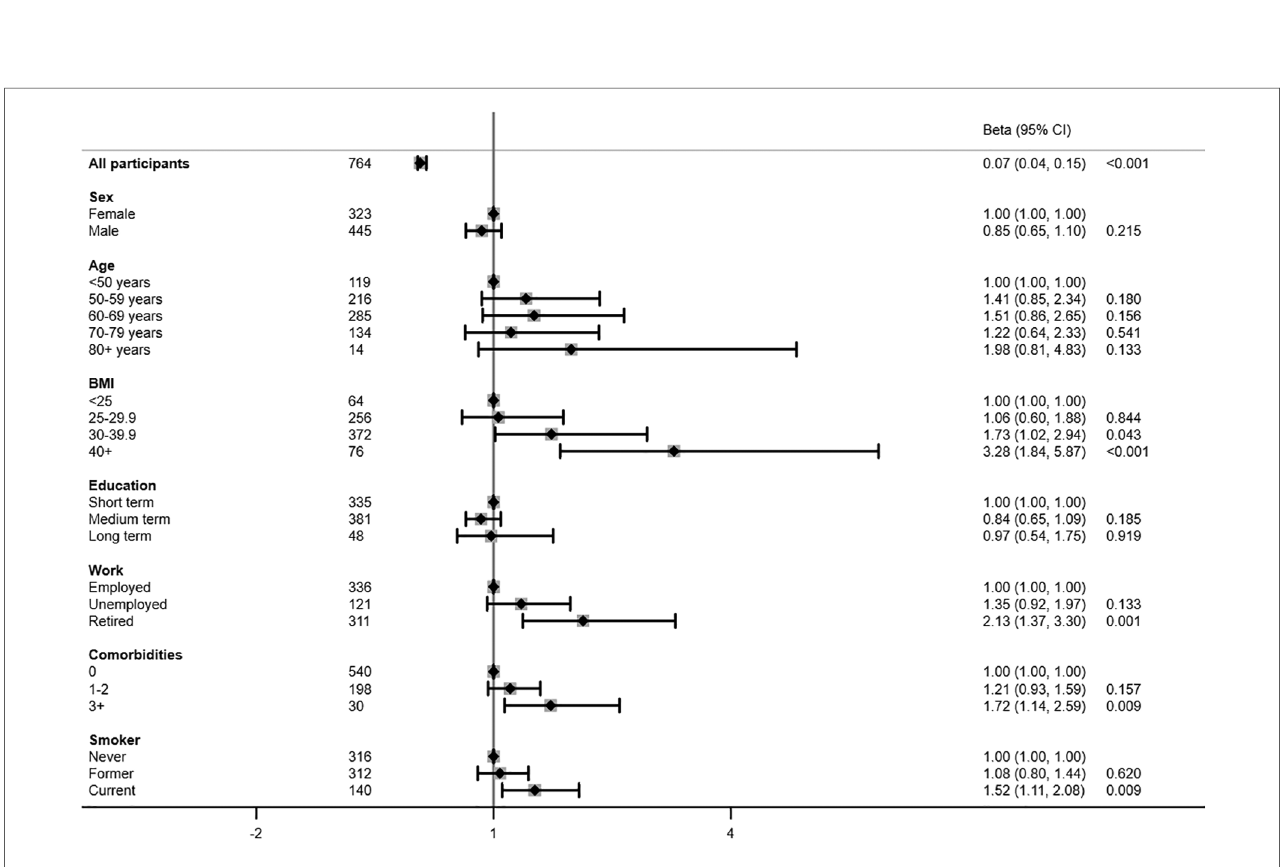
FIGURE 3 Risk factors associated with a high-risk physical activity pro fi le presented in prevalence rate ratios mutually adjusted for all other risk